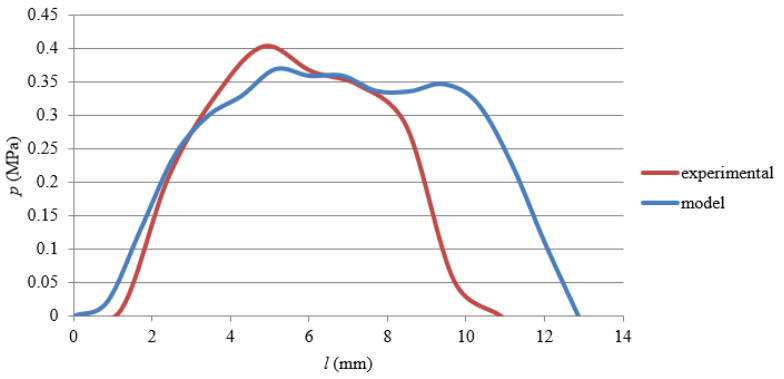
Figure 16. Surface pressure values as a function of distance for dropping an apple from a height of 10 mm on a wooden substrate.